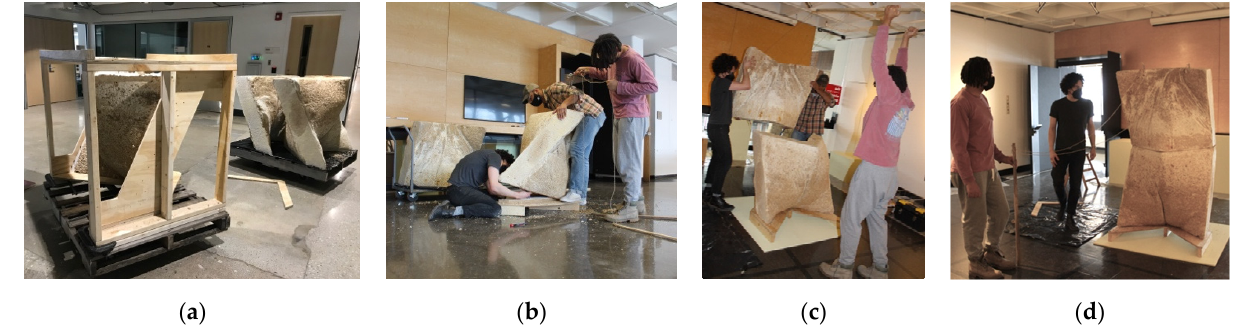
Figure 14. Assembling the prototype: ( a ) palletized units and formwork apparatus before shipping to the UVA; ( b ) stringing cables from base plate through lower wall unit; ( c ) stacking two wall units while pulling tension cables through the assembly; ( d ) stacked undulating wall units before post-tensioning. Photos by the author and Leila Ehtesham.